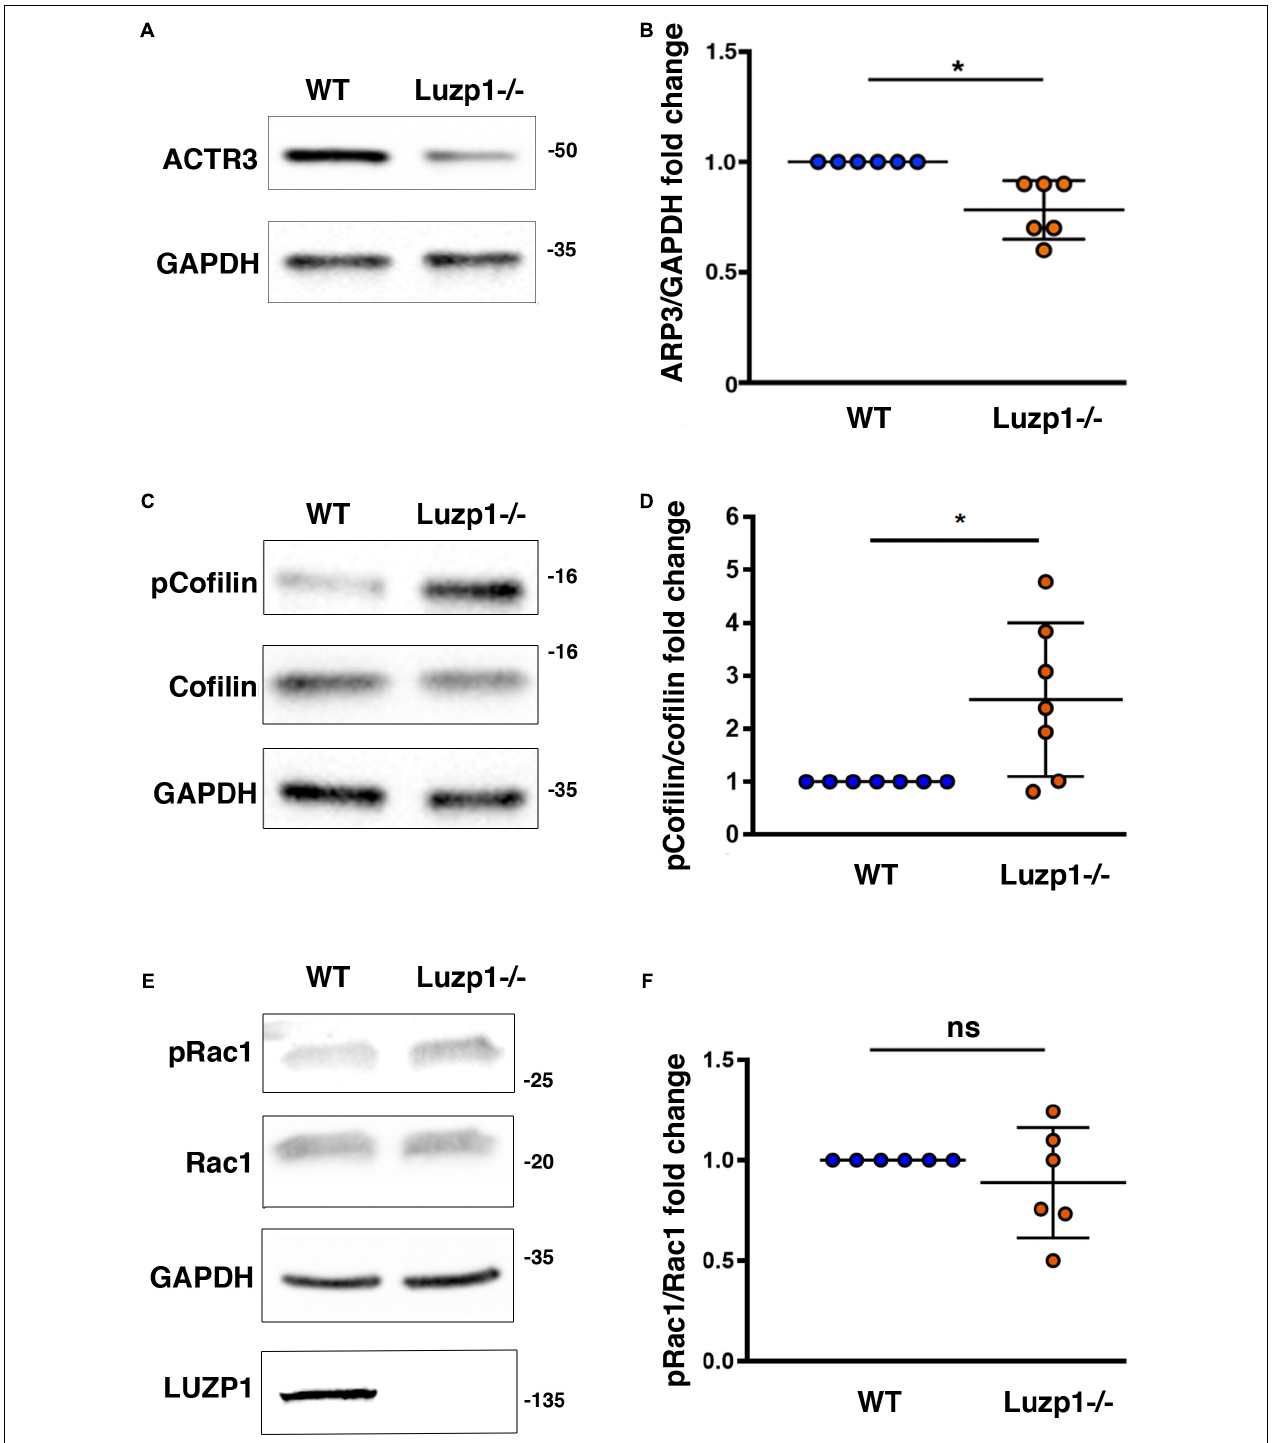
FIGURE 5 | Changes in levels of proteins related to actin polymerization in Luzp1 − / − cells. (A,C,E) Representative western blot of total lysates of Shh-LIGHT2 WT and Luzp1 − / − cells. Note a reduction in ACTR3 ( A ) and an increase in phosphorylated Cofilin (p-Cofilin):Cofilin ratio ( C ) in Luzp1 − / − cells. No significant changes were observed in phosphorylated Rac1 (pRac1) (E) . Specific antibodies against ACTR3, Cofilin, phospho-Cofilin, pRac1, Rac1 actin and GAPDH were used. Molecular weight markers (kDa) are shown to the right. (B,D,F) Graphical representation of the fold change of ACTR3/GAPDH ratios obtained in ( A ), the p-Cofilin/Cofilin ratios obtained in (C) and the pRac1/Rac1 ratios obtained in (E) . Data from at least three independent experiments pooled together are shown. P -values were calculated using two-tailed unpaired Student’s t -test. ns: no significant. The graphs in (B,D,F) represent the Mean and SEM. ∗ P < 0.05.